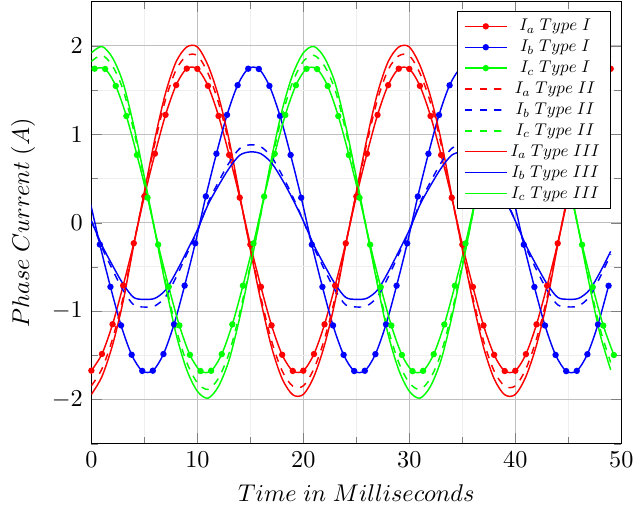
Figure 8. Open circuit 3D FEA magnetization plot for the proposed core